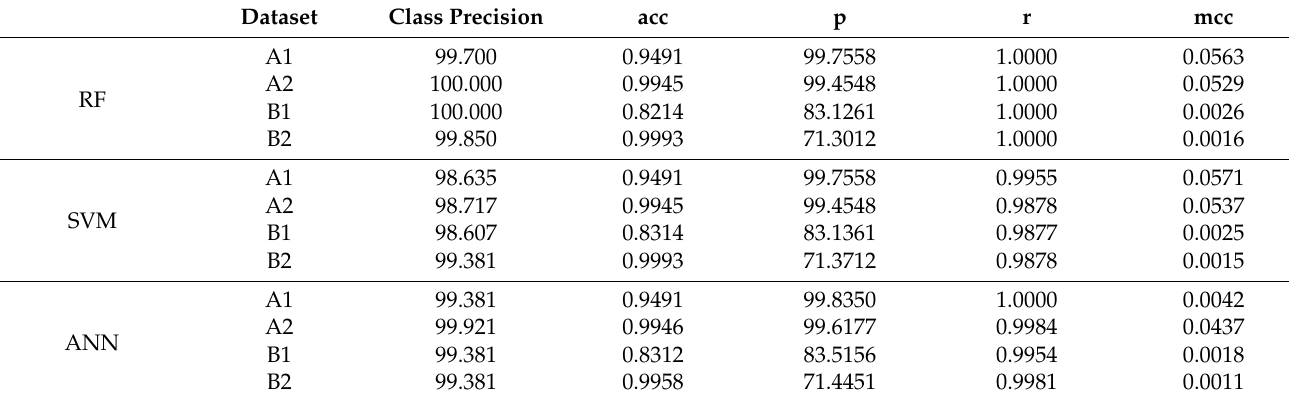
Table 4. Values of merit for predictive models developed with algorithms FR, SVM, and ANN. These values of merit were obtained with datasets A1, A2, B1, and B2 and two values for class Y.